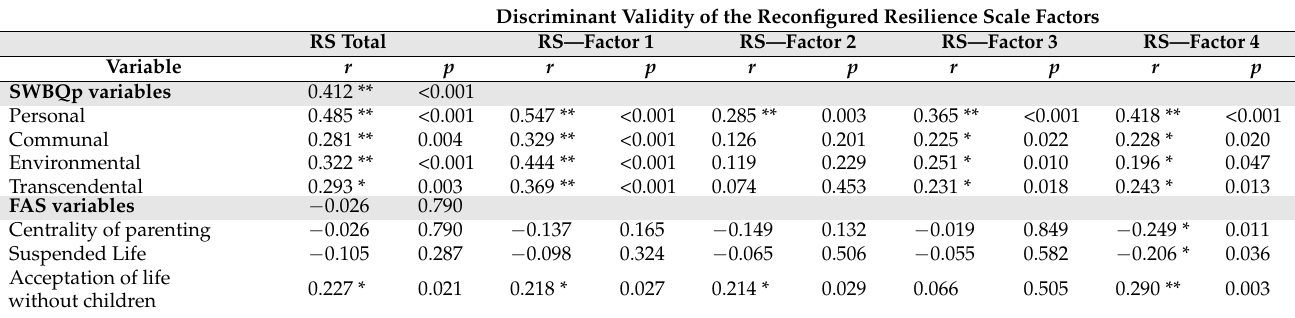
Table 8. Discriminant validity of the reconfigured Resilience Scale factors using SWBQp and FAS